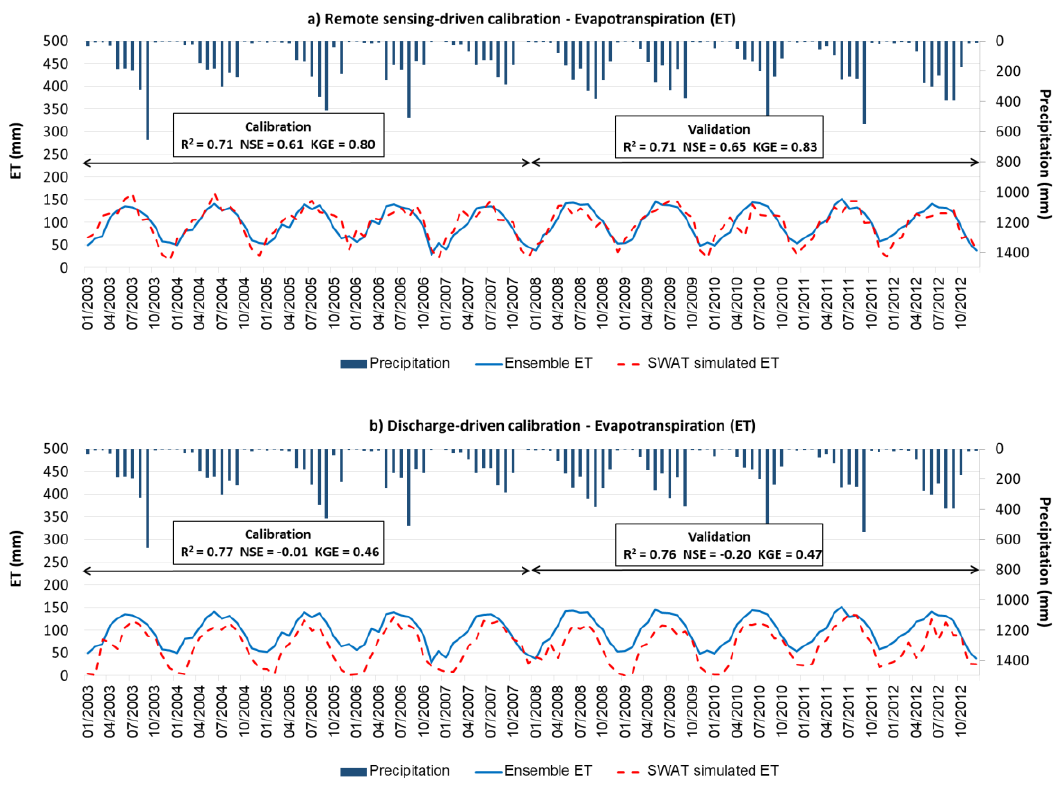
Figure 7. Temporal variability estimated from SWAT and the “observed” values from remote sensing in ( a ) remote sensing-driven calibration, and ( b ) conventional discharge-driven calibration.